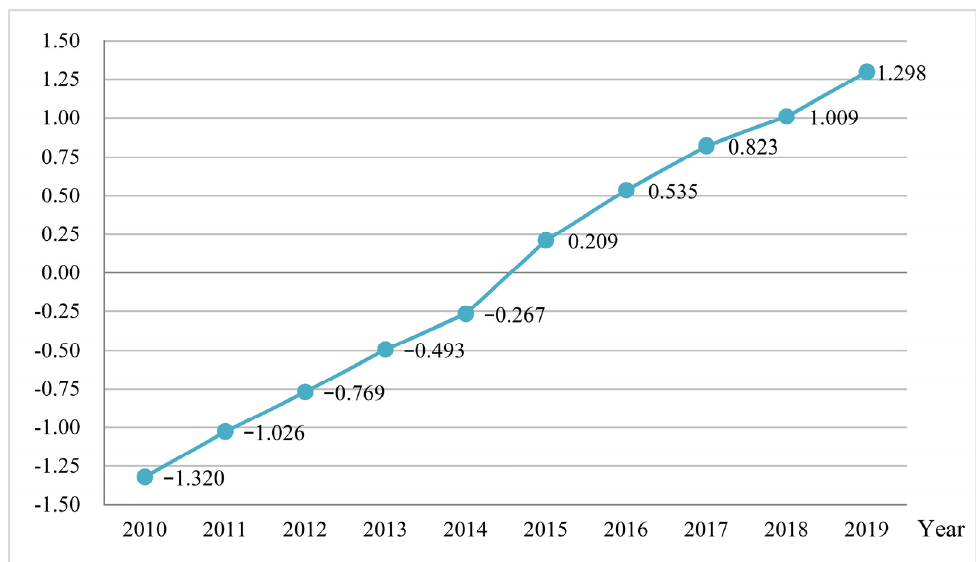
Figure 5. Comprehensive score of the driving forces of construction land in the TWL region (2010–2019).